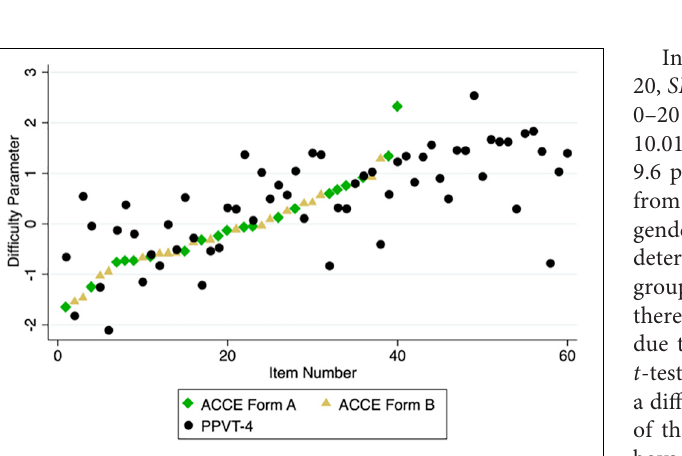
FIGURE 6 | Difficulty parameters of items in the ACCE-V Form A, ACCE-V Form B, and the PPVT-4 in the order in which the items are